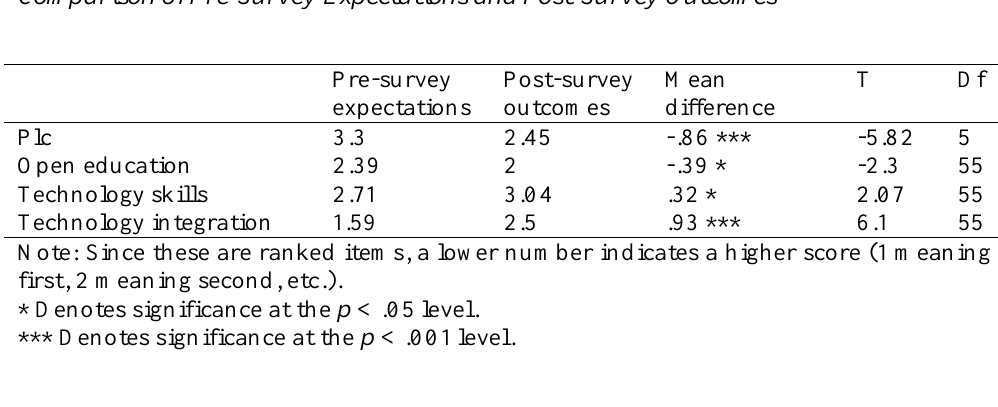
Comparison of Pre-Survey Expectations and Post-Survey Outcomes